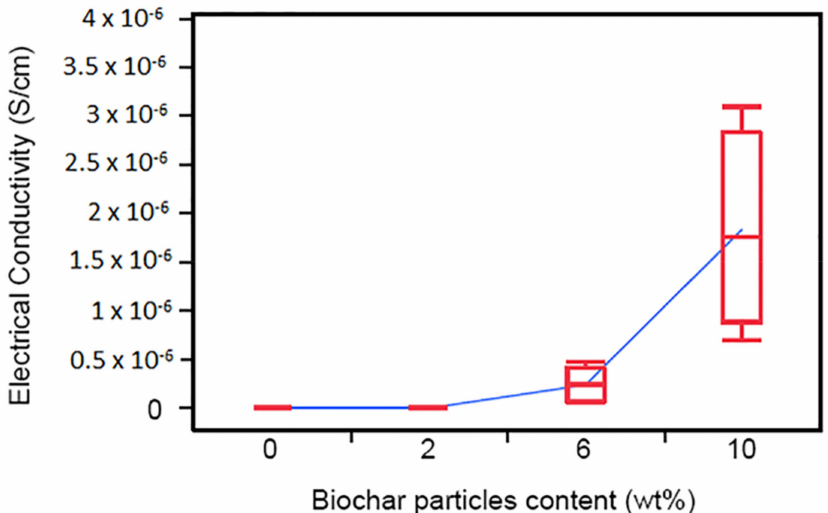
Figure 8. Electrical conductivity of biochar filled PVA composites filled with 2%, 6% and 10% biochar filler, respectively. An increase in conductivity is observed with increase in loading rate of biochar. Figure taken from [27] with permission to use from SagePub Publications